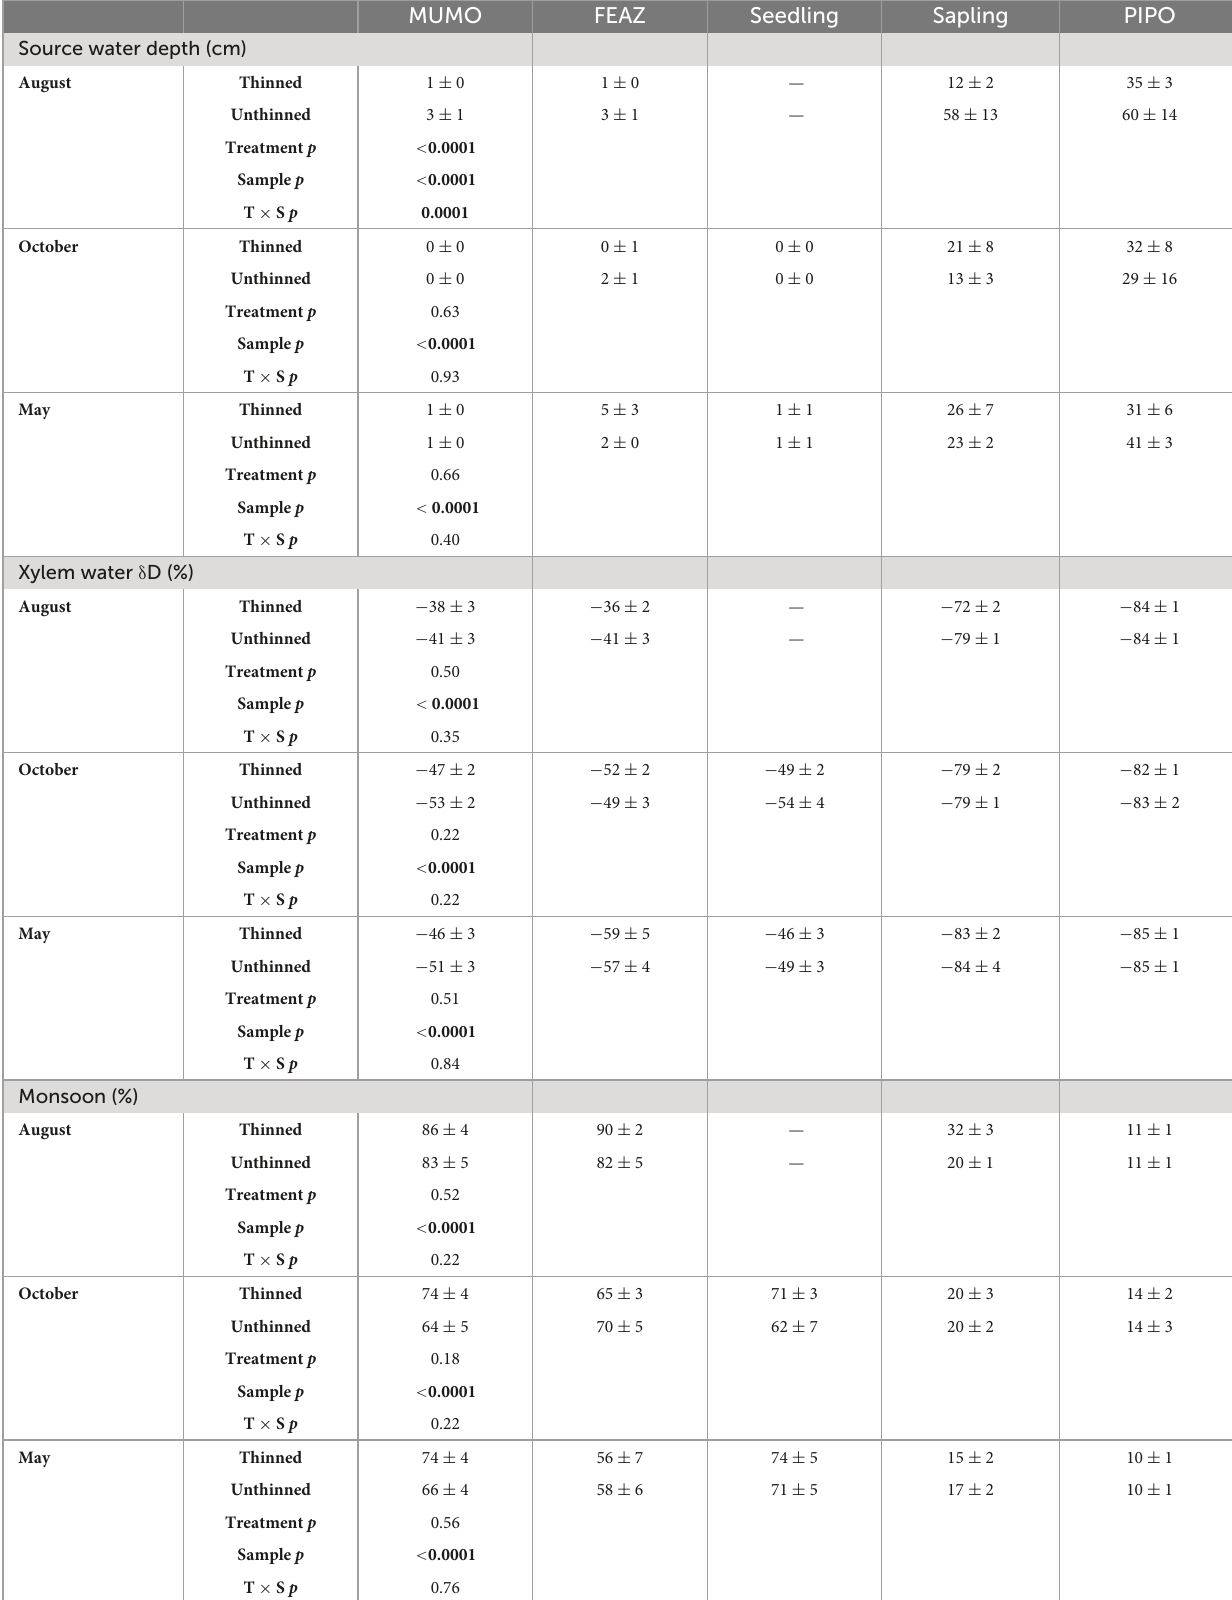
TABLE 2 Mean ( ± SE) xylem water data from the Fort Valley Experimental Forest near Flagstaff, AZ, USA. MUMO FEAZ Seedling Sapling